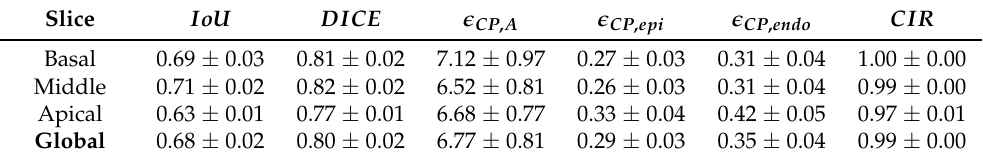
Table 1. Averaged object detection metrics (Mean ± St Dev) over the 5 folds evaluated in the test set. Slice